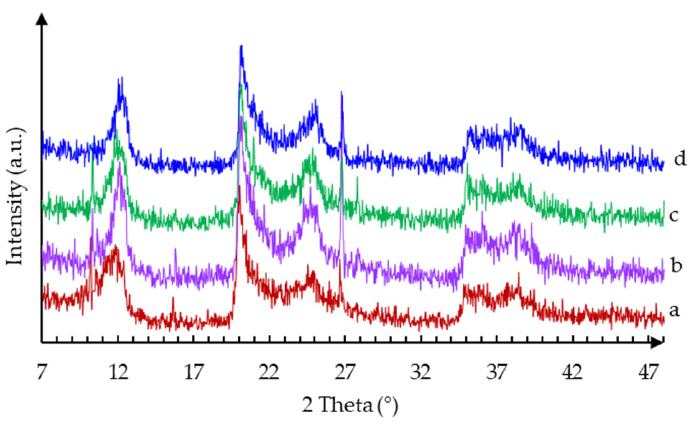
Figure 1. XRPD pattern of H (a), H_HCl_8M (b), H_H 2 SO 4 _0.5M (c), and H_NaOH_0.5M Figure 1 . XRPD pa tt ern of H (a), H_HCl_8M (b), H_H 2 SO 4 _0.5M (c), and H_NaOH_0.5M (d).